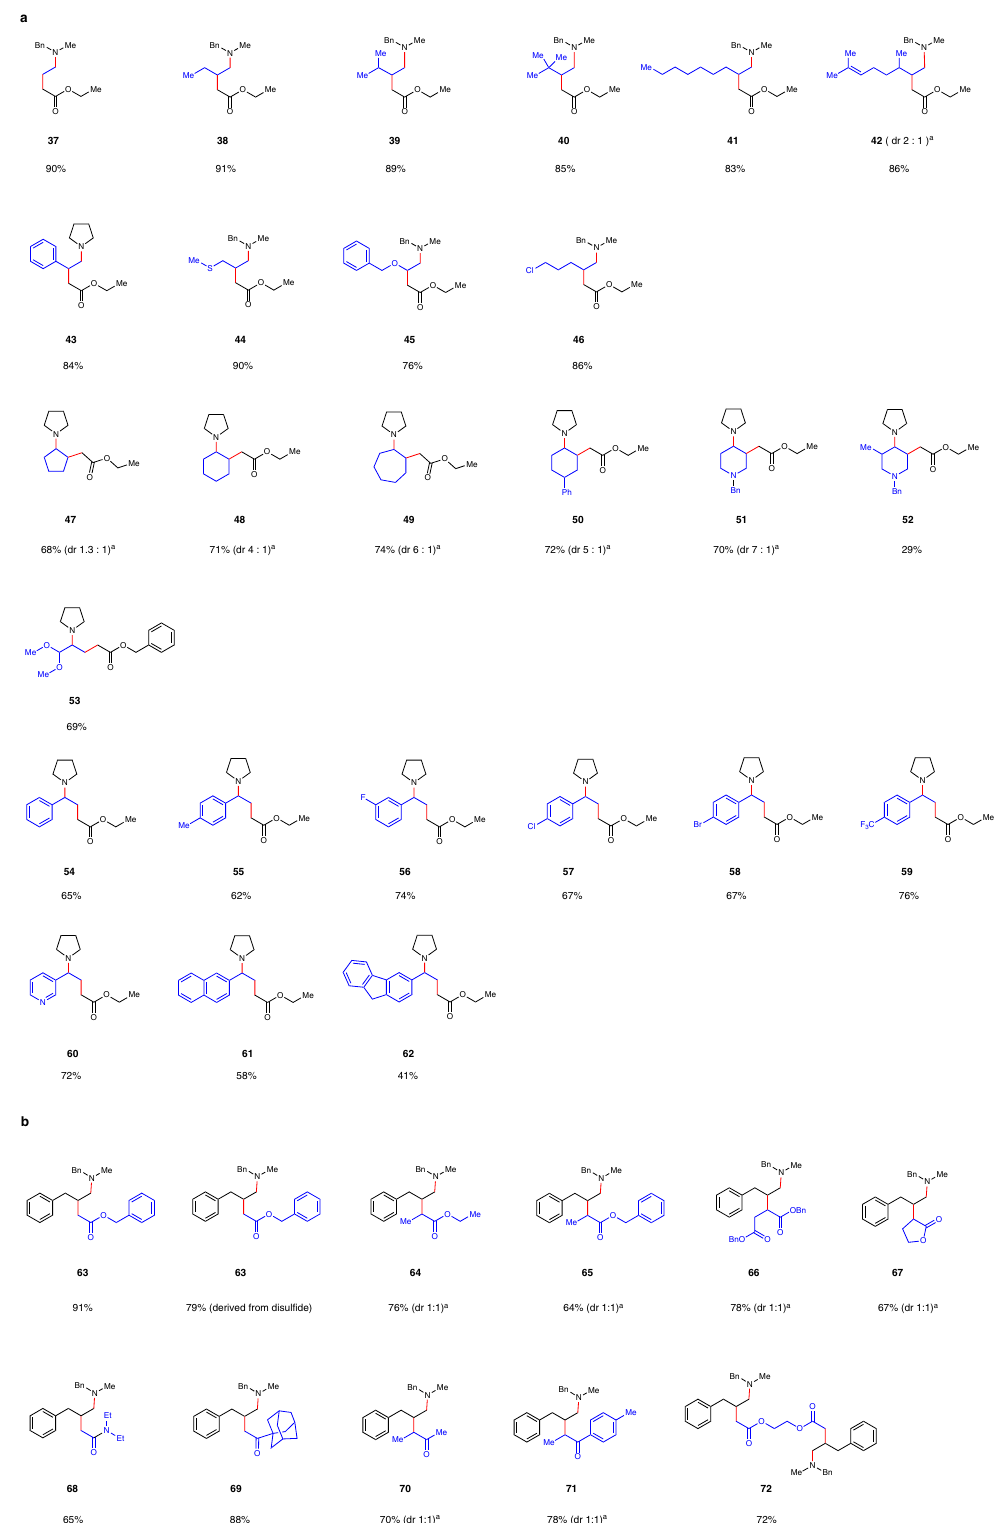
Fig. 3 Scope of the radical homo Mannich reaction. a Scope of the aldehyde and ketone partner. b Scope of the thiol partner. a the dr value was based on 1 H